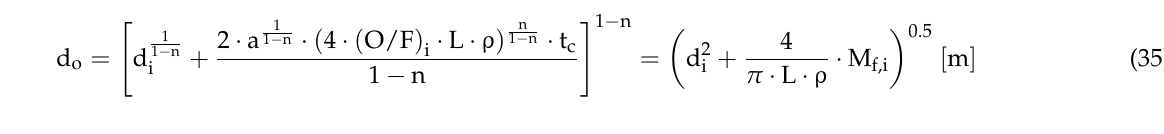
. . r i and m o,i and (O/F) = (O/F) i = 3.2.